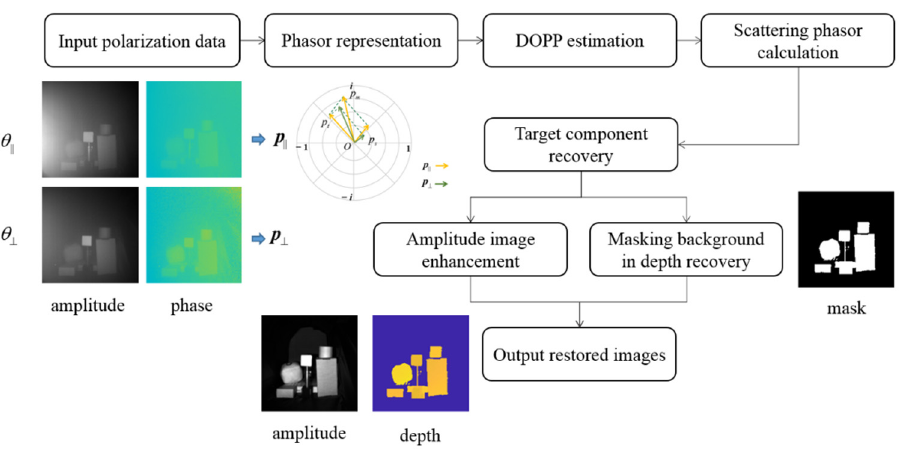
Figure 2. Pipeline for the polarization phasor imaging method. DOPP is an abbreviation for degree of polarization phasor.